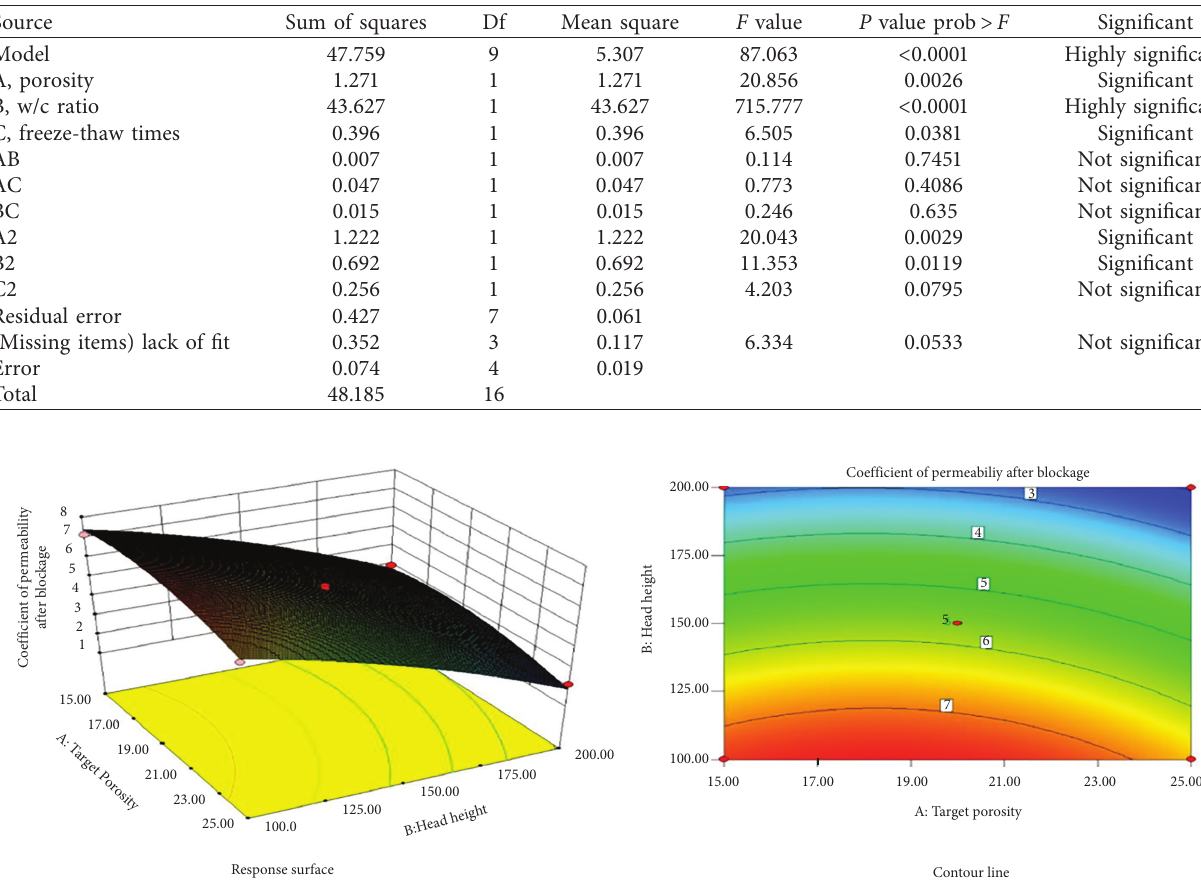
Table 14: Regression equations for the analysis of variance and significance test.